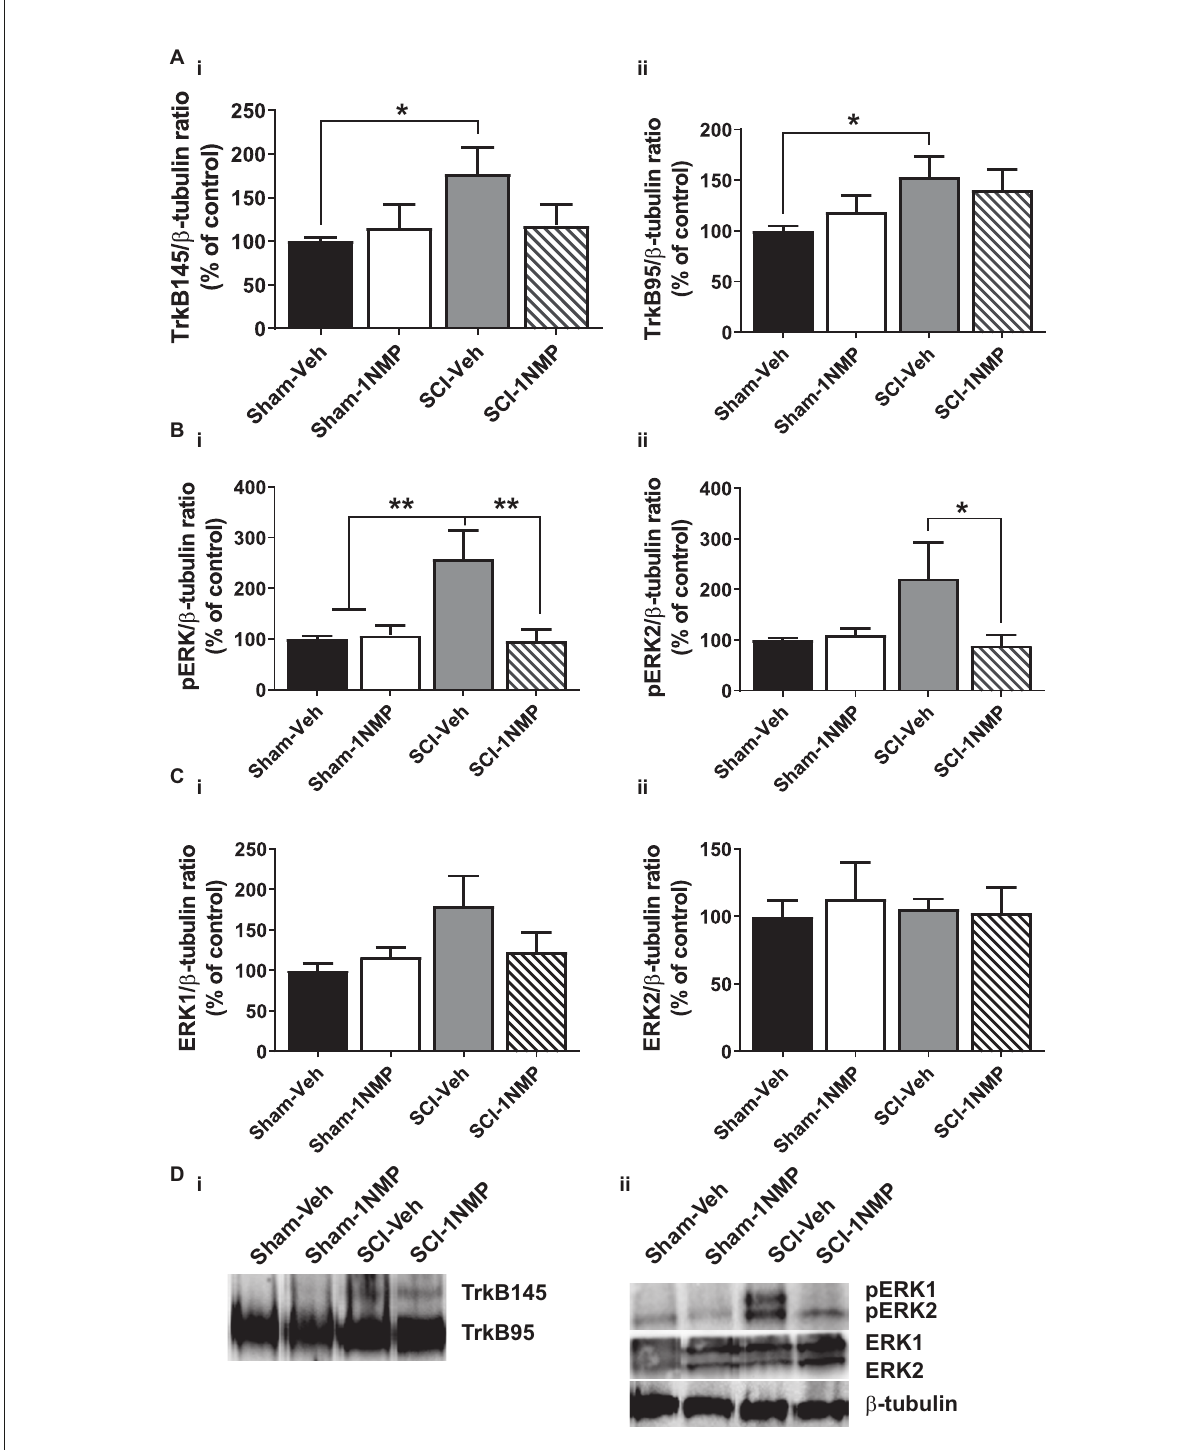
FIGURE7 Late inhibition of TrkB signaling modestly reduces spinal TrkB and pERK expression. (A) (i,ii) TrkB expression was significantly increased in the lumbar spinal cord of SCI-Veh mice compared to Sham-Veh subjects only at 34 dpo (* p < 0.05, unpaired t test ). (B) (i,ii) Both pERK1 and pERK2 levels were reduced following 1NMP treatment compared to vehicle treatment 16–21 days after SCI (* p < 0.05, and ** p < 0.01, 1-way ANOVA). However, only pERK1 levels were significantly increased in SCI-Veh mice in comparison to Sham subjects (** p < 0.01, 1-way ANOVA). (C) (i,ii) Total ERK expression levels were unchanged among the four experimental groups ( n = 7, each group). (D) Representative images of (i) TrkB, and (ii) pERK1/2, ERK1/2, and β -tubulin (loading control) Western blot are